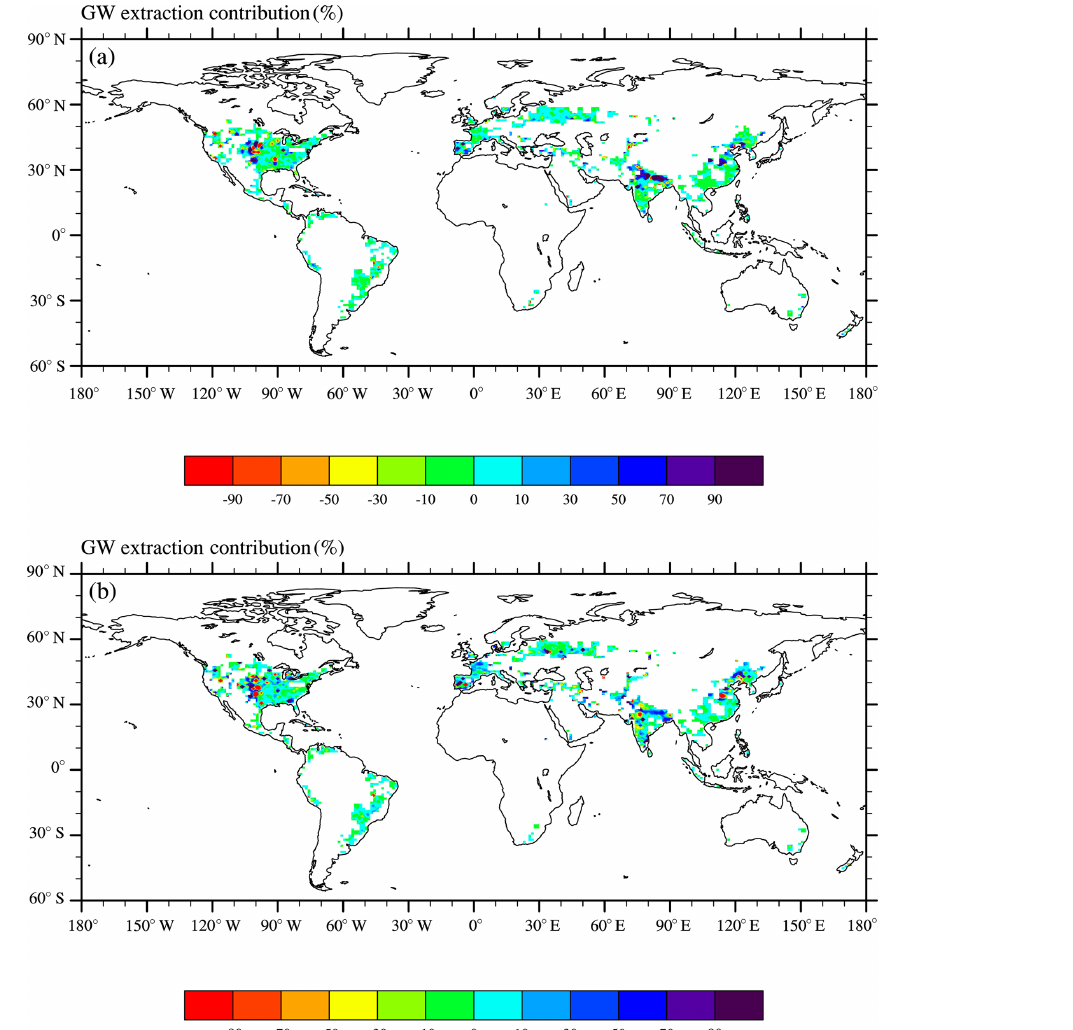
Figure 8. The relative contribution of groundwater extraction to (a) surface and (b) deep soil moisture trends